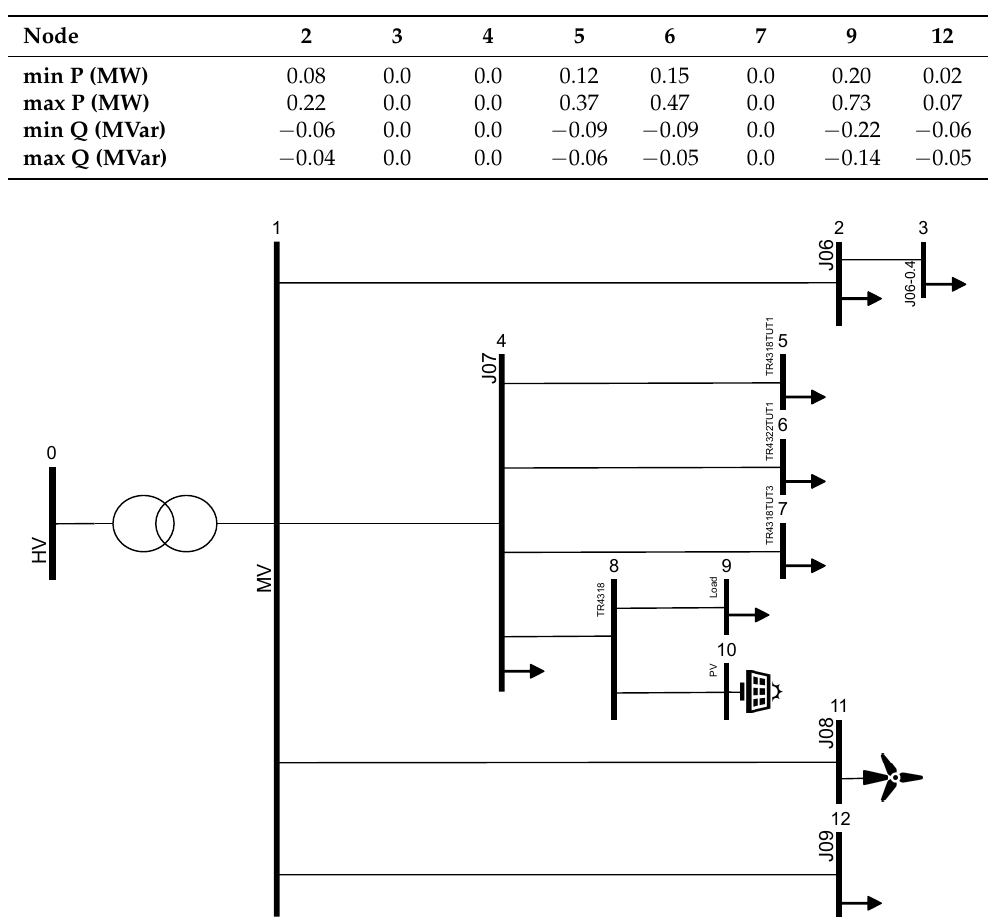
Table 1. Minimum and maximum values of active and reactive power of load profiles.